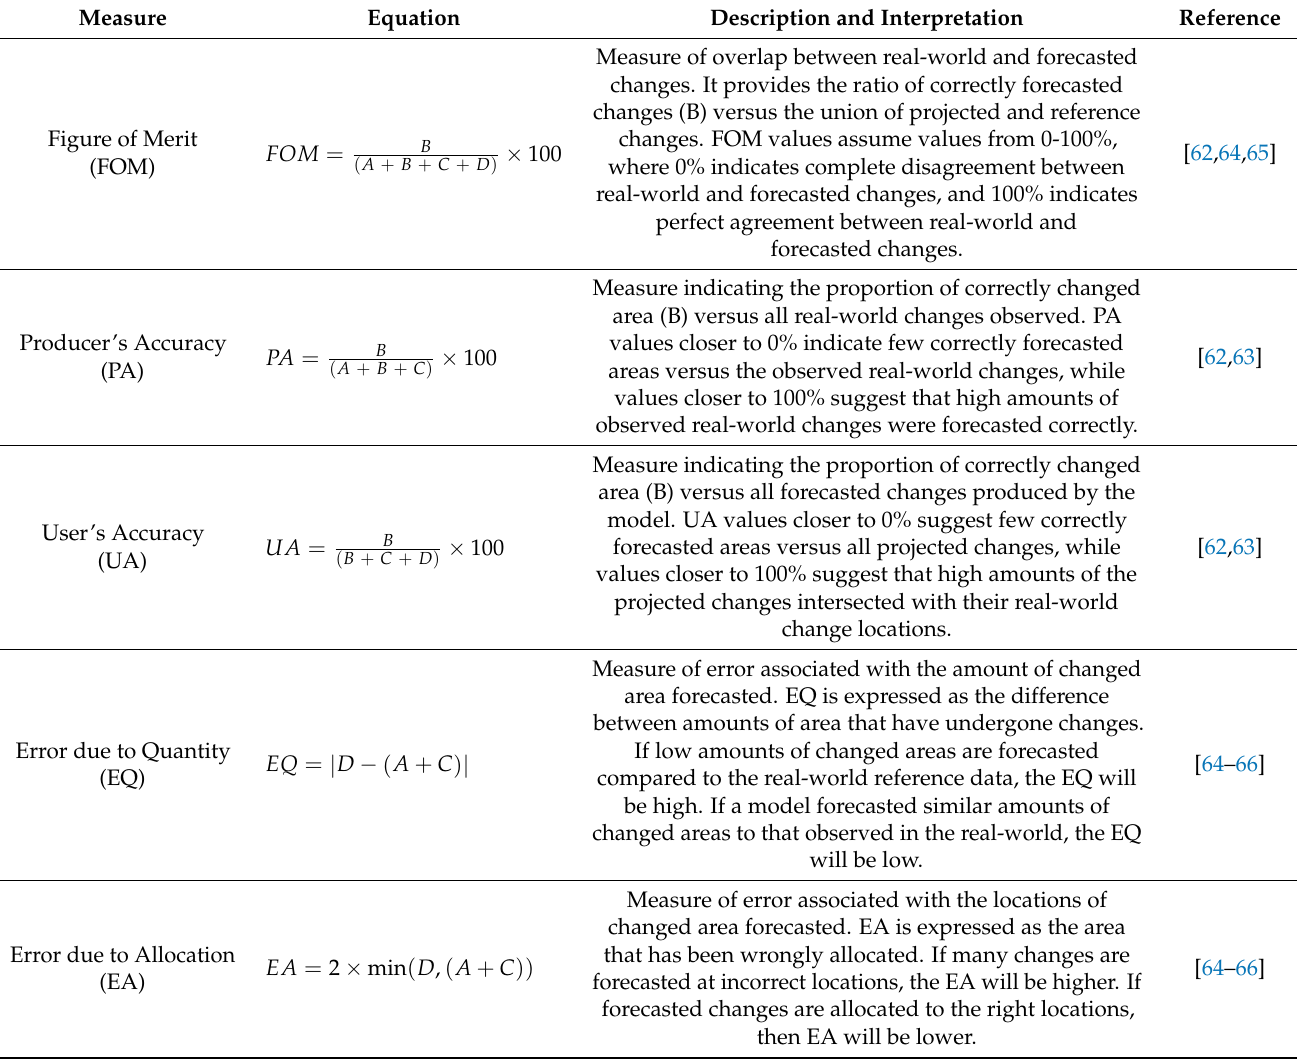
Table A1. Equations of measures used in model